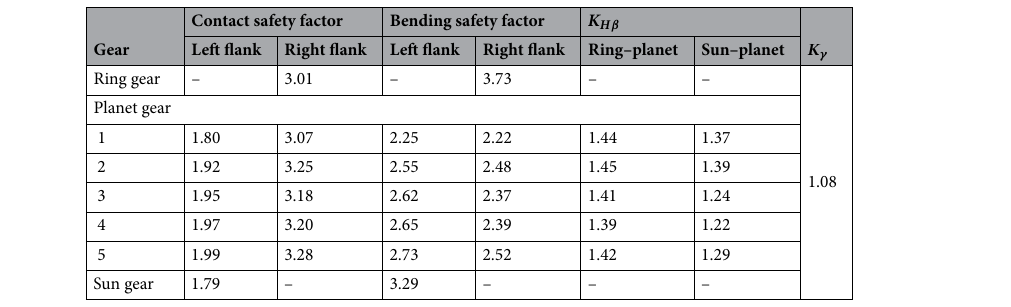
Table 3. Analytical results of the proposed flexible pin